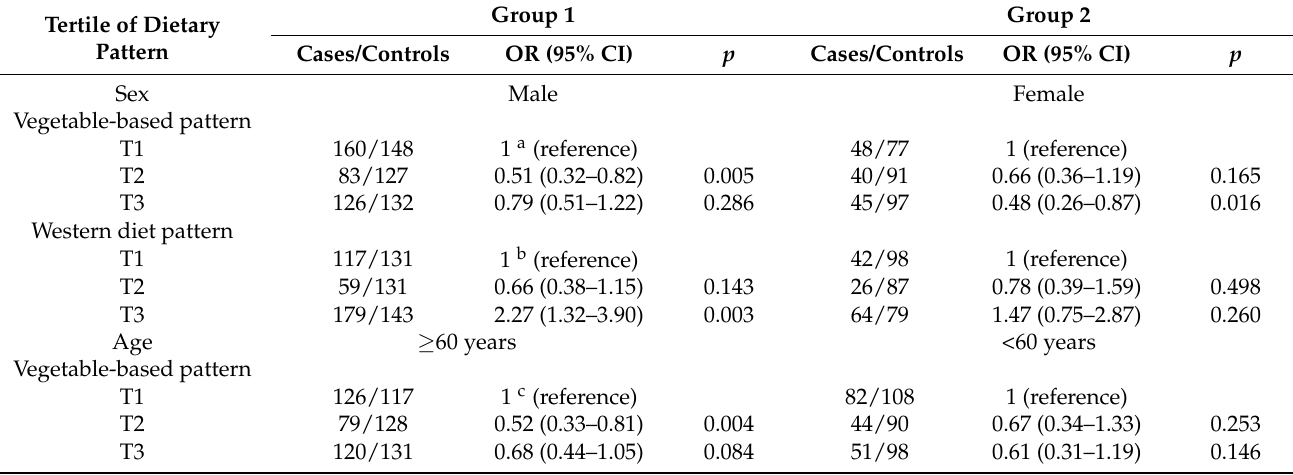
Table 6. Multivariable adjusted ORs and 95% CI for hepatocellular carcinoma according to dietary pattern tertile stratified by sex and